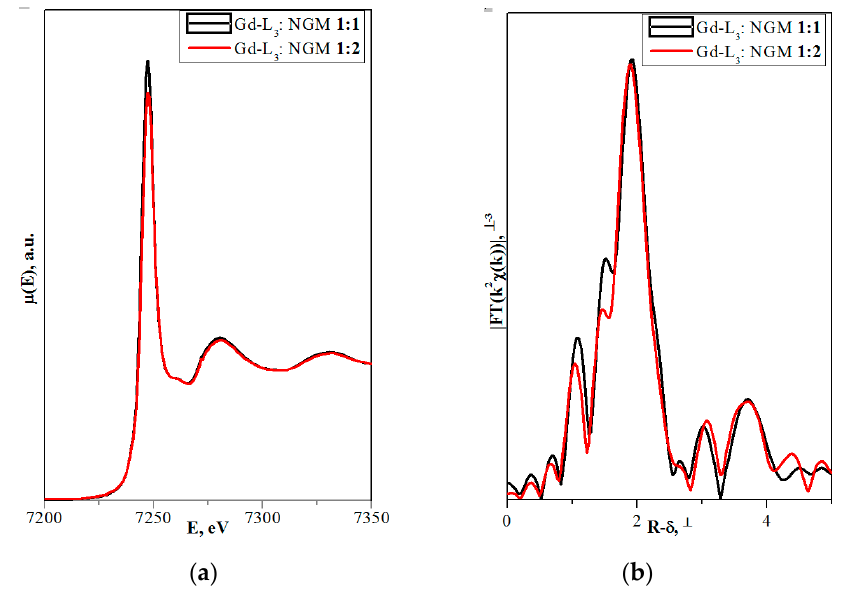
Figure 4. Gd L 3 -edge-normalized ( a ) XANES spectra and ( b ) EXAFS Fourier transforms for (Na 0.5 Gd 0.5 )MoO 4 (NGM) 1:1 (black curves) and NGM 1:2 (red curves) samples.